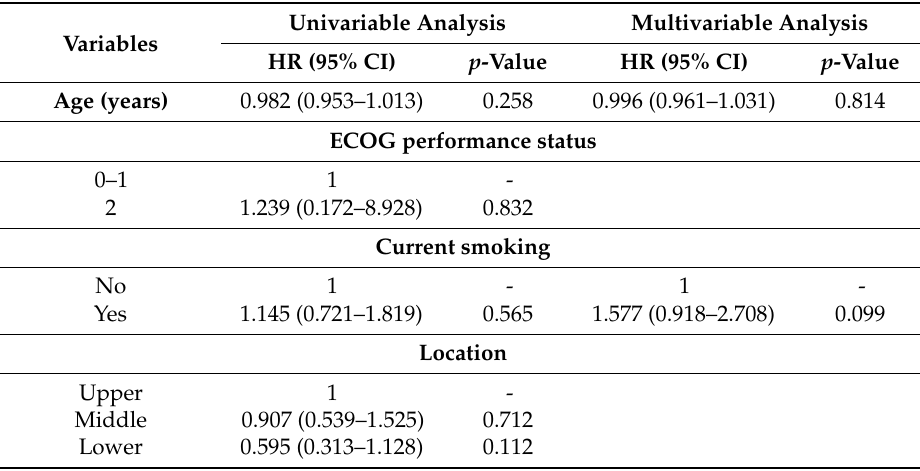
Table 2. Univariable and multivariable analysis for overall